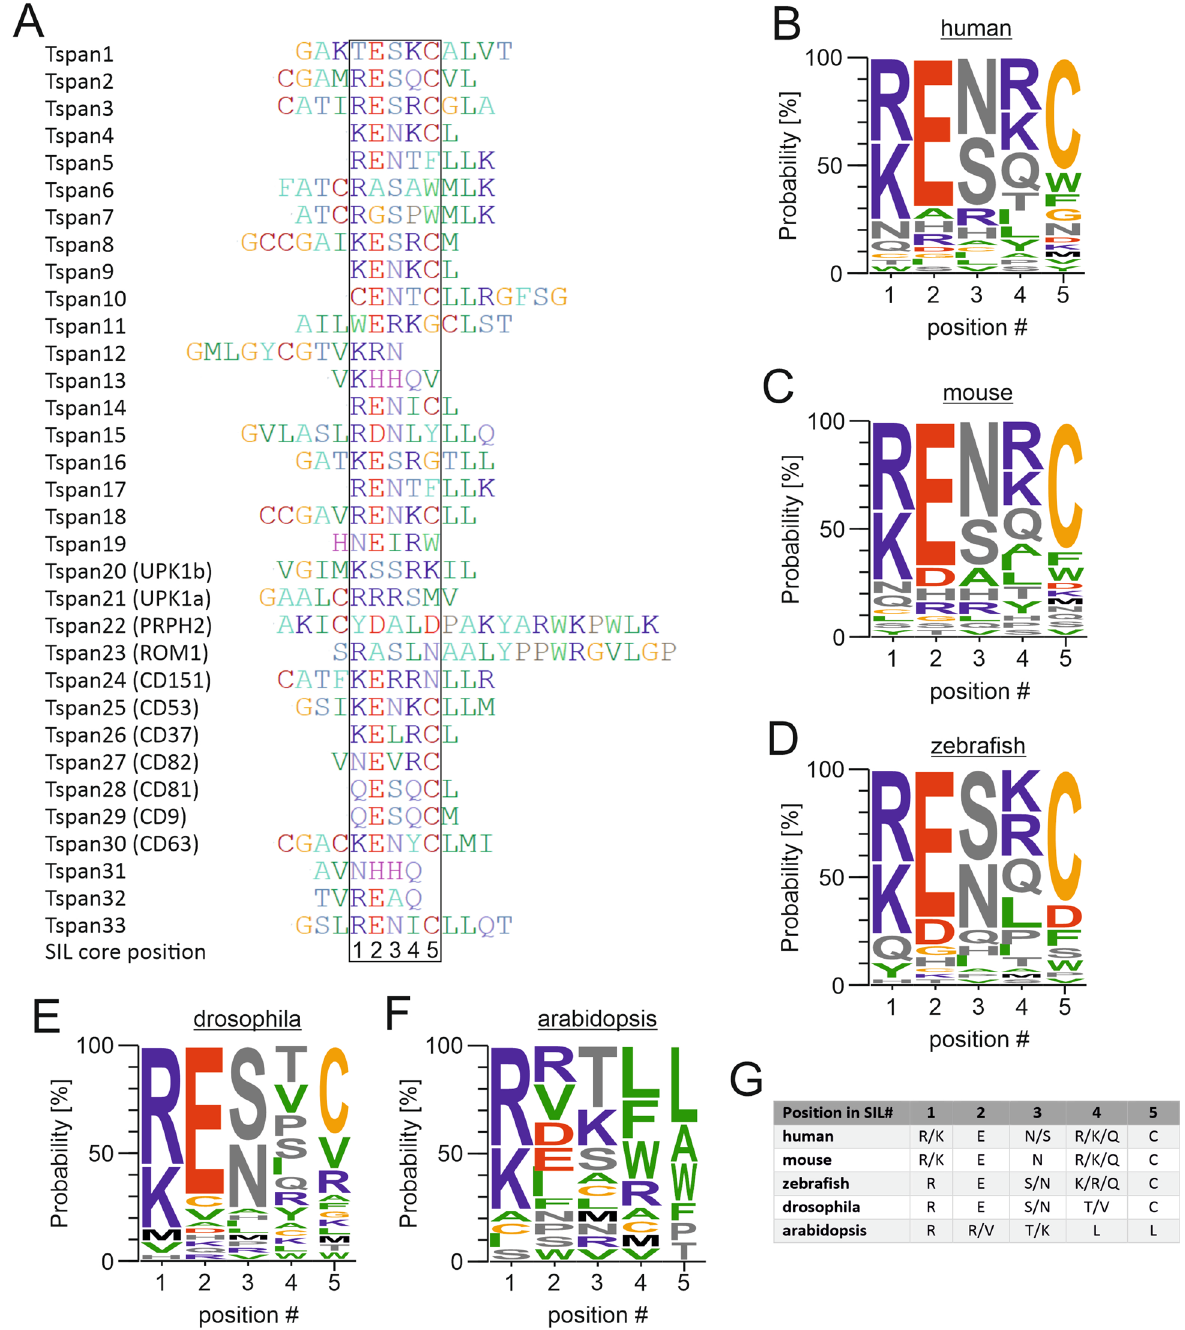
Figure 2. The SIL core sequence. ( A ) Alignment of the SILs from human tetraspanins (SILs segments are defined as in Hochheimer et al. 11 ), as described in text, yields an amino acid core sequence with five positions (box). Tspan31 did not feature any of the alignment criteria and was aligned with reference to its similarity to Tspan13. In Tspan12, Tspan31 and Tspan32 some of the positions 4 and 5 are empty, as these amino acids are supposed to be integral part of TMS3. For the SIL alignments of other species see Fig. S1. ( B – F ) Residue probability in the SIL core of human ( Homo sapiens ), mouse ( Mus musculus ), zebrafish ( Danio rerio ) drosophila ( Drosophila melanogaster ) and Arabidopsis ( Arabidopsis thaliana ) tetraspanins. ( G ) SIL core consensus sequences. Part of the consensus sequence are amino acids occurring with a frequency f equal or higher than the mean frequency plus one time the frequencies standard deviation (f ≥ f mean + SD). In cases of more than one, they are listed in order of abundancy from high to low. The alignment was created using BioEdit 28 v7.0.5 (http:// www. mbio. ncsu. edu/ BioEd it/ bioed it. html) and the illustration of residue frequency was done using Weblogo 33 3.7.4 (https:// weblo go. berke ley. edu/ logo.